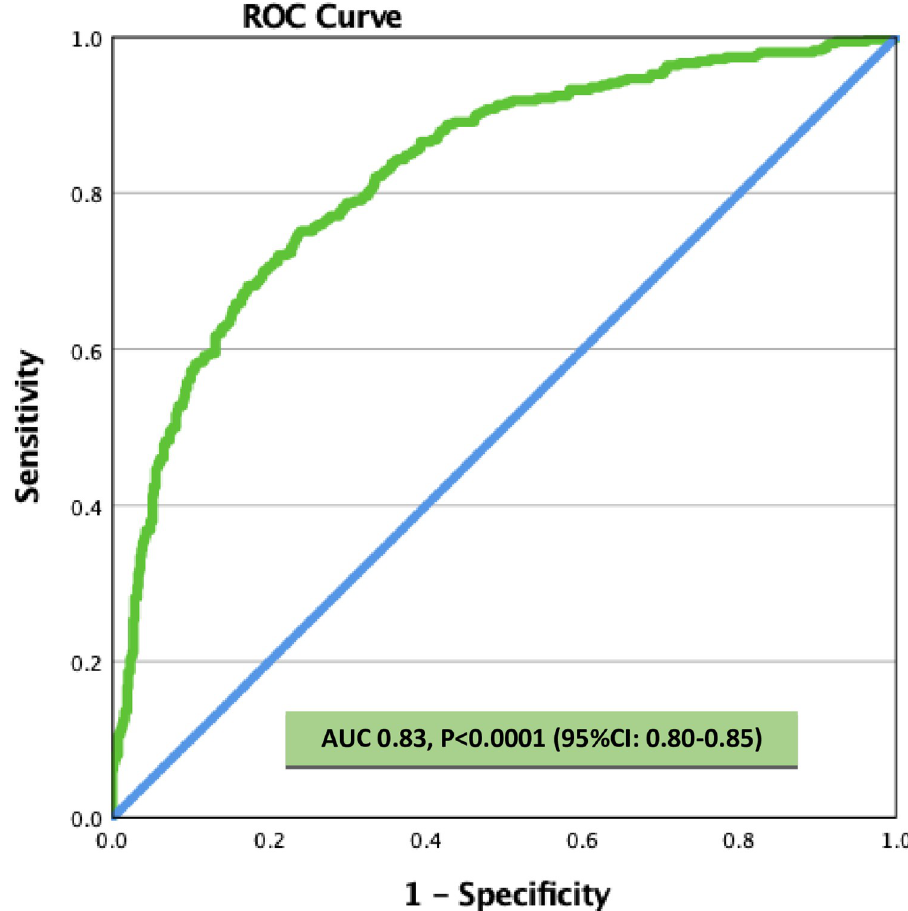
Fig 2. ROC CURVE- To predict accuracy of 90-day poor outcome from the